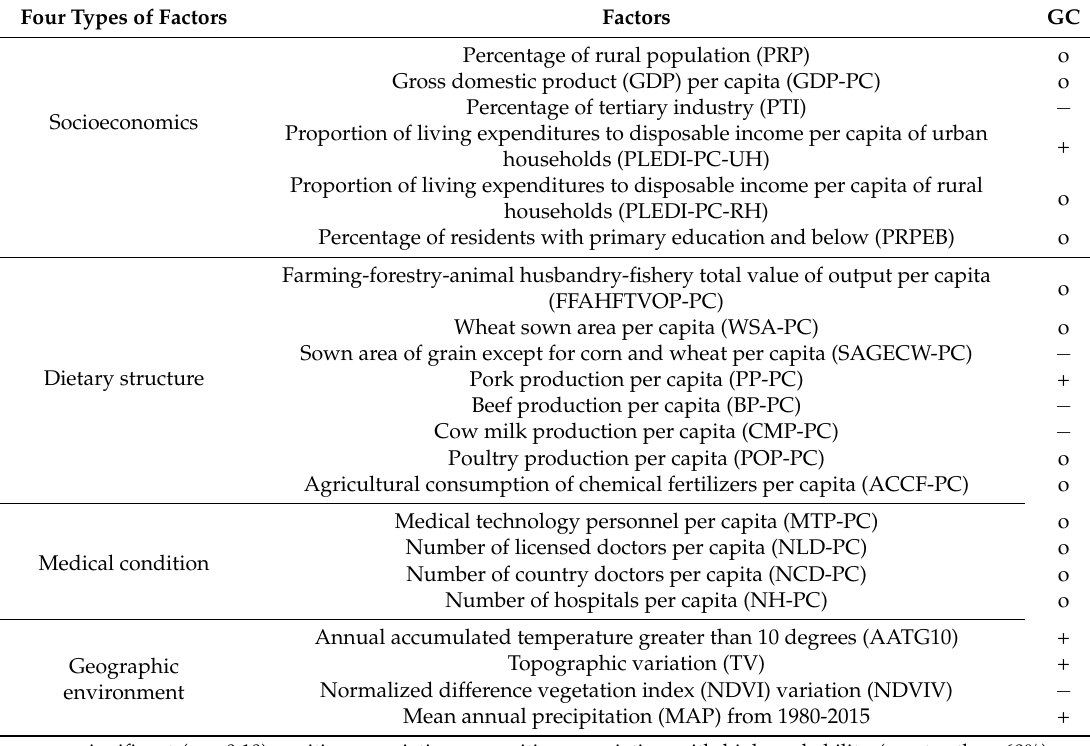
Table 3. Summary of the association of risk factors and